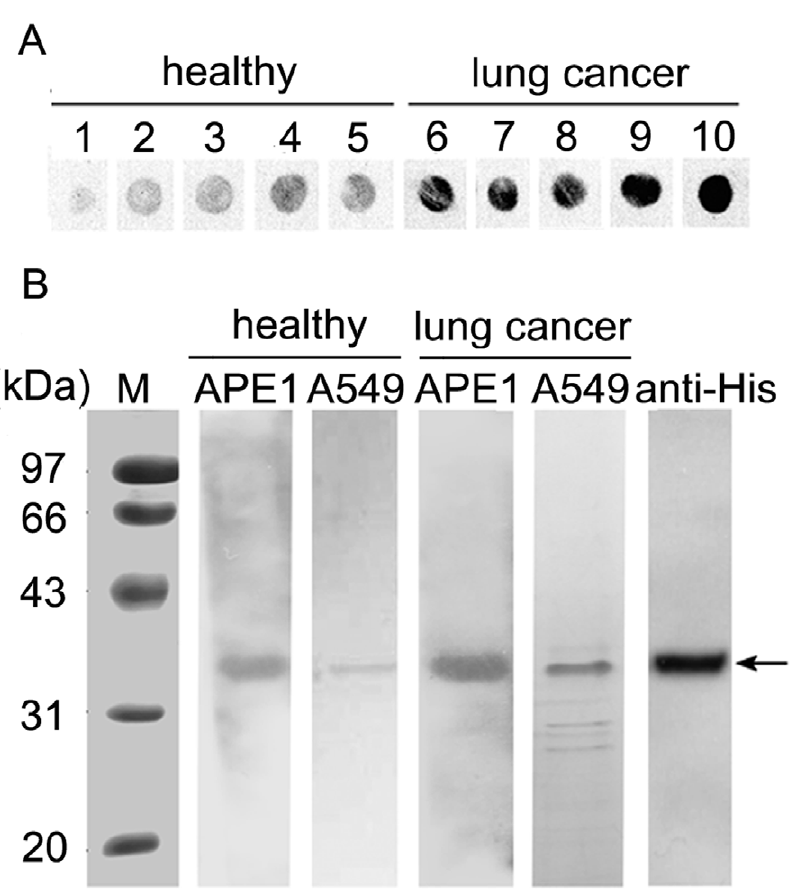
Figure 1. Dot blot and Western blot for identifying serum APE1-AAbs. A, Representative results of detection of sera APE1-AAbs by dot blot assay. Lanes 1 , 5: serum of healthy subjects. Lanes 6 , 10: serum of NSCLC patients. B, Serum APE1-AAbs of healthy and NSCLC patients were detected by Western blot analysis. Lane M, protein molecular weight markers; APE1, APE1 fusion protein with His tag; A549, total cell protein extracted from A549 cells; Anti-His, APE1 fusion protein detected by His antibody.